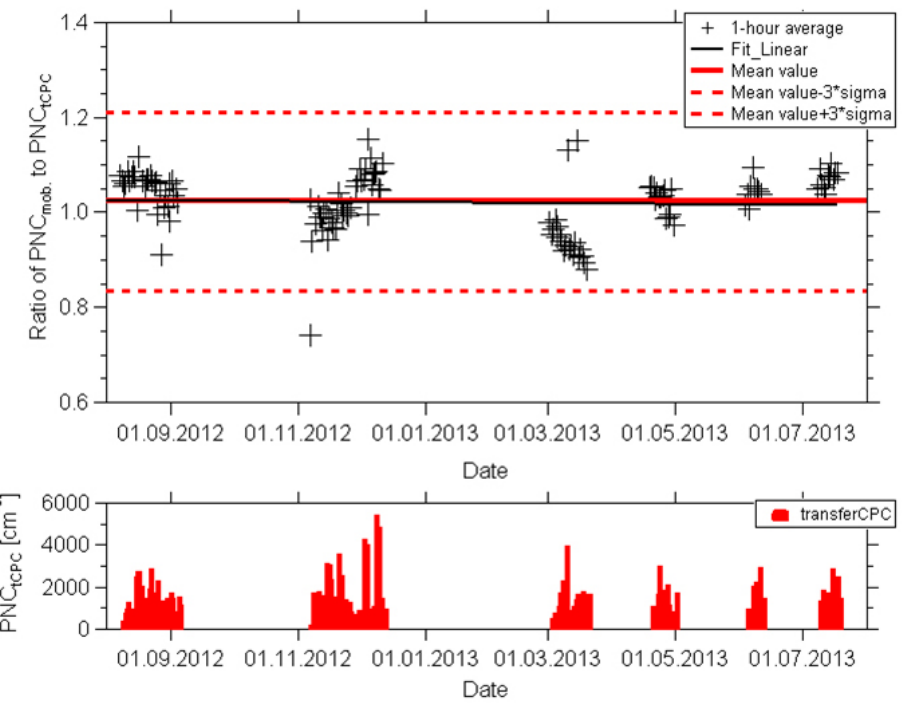
Fig. 7. Results from the diffusion screen measurements for the Annaberg-Buchholz site from 1 August 2012 to 1 August 2013. Upper graph: quality control chart shows entire mean value (red solid line), 99th confidence interval (red dashed line), and linear fit (black solid line) adapted from 1h averages (black crosses). Lower graph: time series of the PNC from the transfer